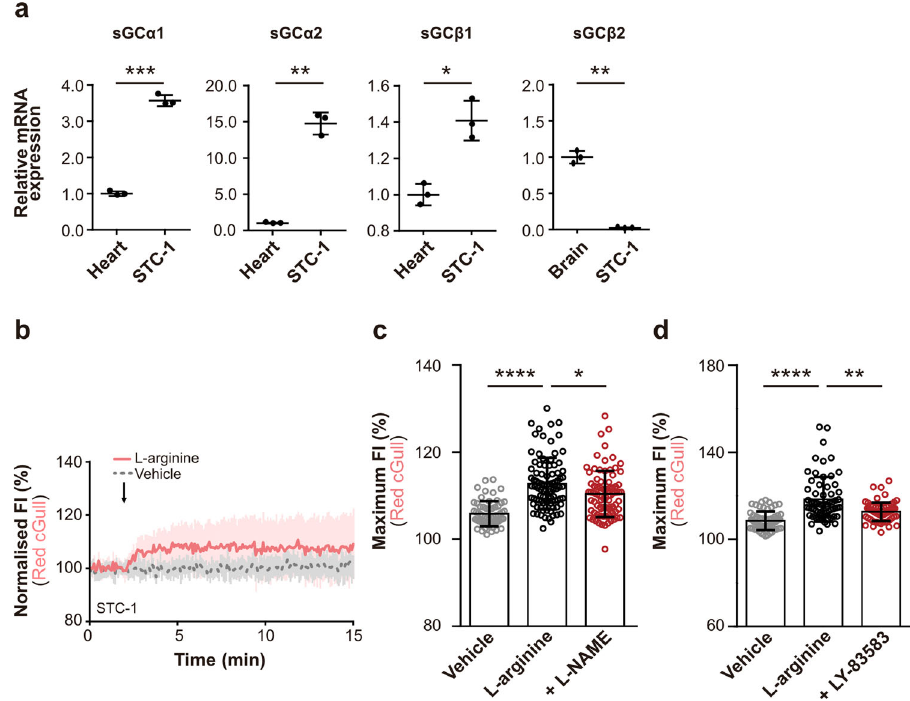
Fig. 5 L -arginine potentiates cGMP production in STC-1 cells via NO-cGMP signalling. a Relative mRNA expression level of cytosolic/soluble guanylyl cyclase (sGC) subunits ( α 1, α 2, β 1, and β 2) in STC-1 cells measured by real-time PCR. GAPDH was used as the internal control. Data are means±standard deviation (s.d.) from three independent experiments. Welch ’ s t -test. From left to right: p = 0.0003 (***), p = 0.004 (**), p = 0.0102 (*), p = 0.0024 (**) (two- tailed). b Time course of FI from Red cGull-expressing STC-1 cells during the application of 10mM L -arginine (solid line) or vehicle (dashed line). Data were means ±s.d. ( L -arginine: n = 60 cells from four independent experiments; vehicle: n = 65 cells from four independent experiments). c Maximum FIs of Red cGull during the application of 10mM L -arginine with 5mM L-NAME (NOS inhibitor). Data were means ±s.d. (vehicle: n = 60 cells from four independent experiments; L -arginine: n = 89 cells from fi ve independent experiments, + L-NAME: n = 84 from fi ve independent experiments). Kruskal – Wallis test with Dunn ’ s multiple comparisons. From left to right: p <0.0001 (****), p = 0.0419 (*). d Maximum FIs of Red cGull during the application of 10mM L -arginine with 1 μ M LY-83583 (sGC inhibitor). Data were means±s.d. (Vehicle and L -arginine: same data as in b , + LY-83583: n = 71 cells from four independent experiments). Kruskal – Wallis test with Dunn ’ s multiple comparisons. From left to right: p < 0.0001 (****), p = 0.0066 (**).